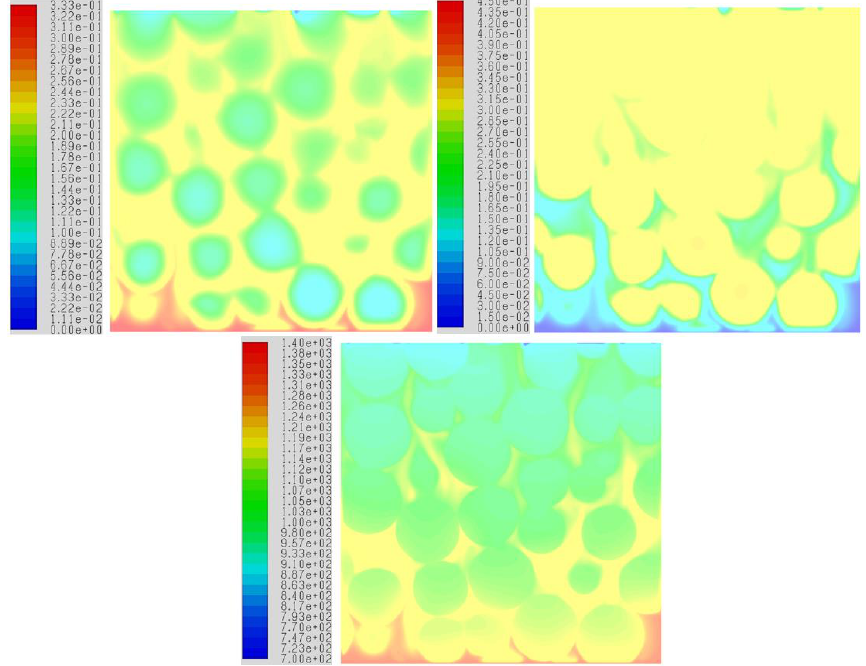
Figure 11. PR-DNS predictions of mole fraction of CH 4 ( top left ), H 2 ( top right ), and fluid temperature (in K) ( bottom ) at (plane y = 0; ε = 0.352) for inlet temperature 1100 °C, through a packed bed of porous spherical particles for steam methane reforming process.